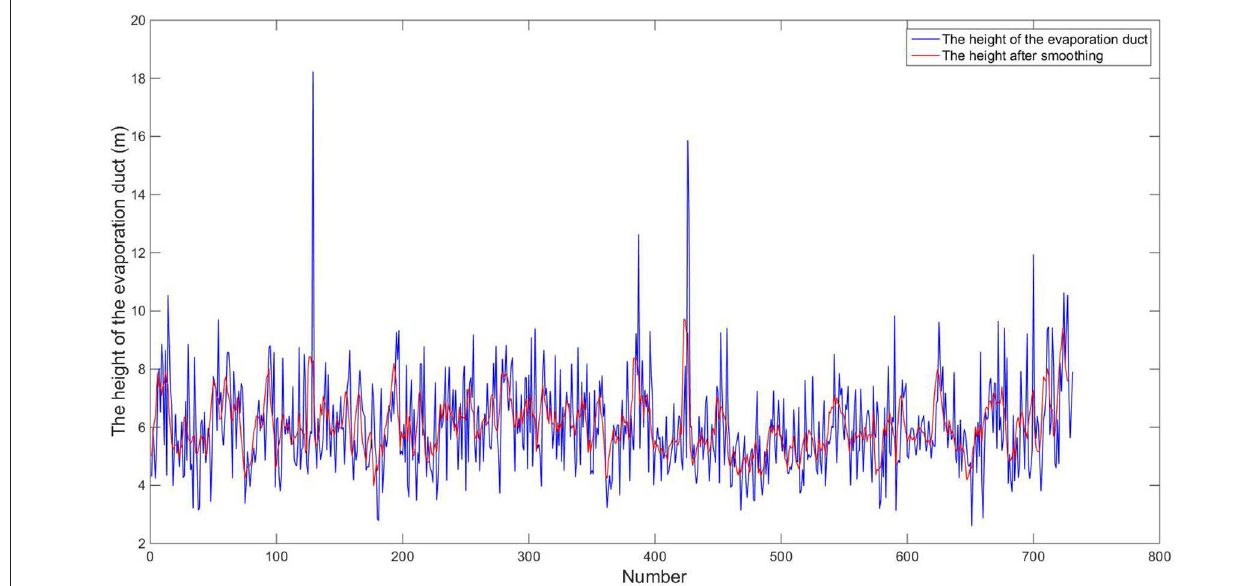
FIGURE 3 | Original evaporation duct heights and heights after smoothing.